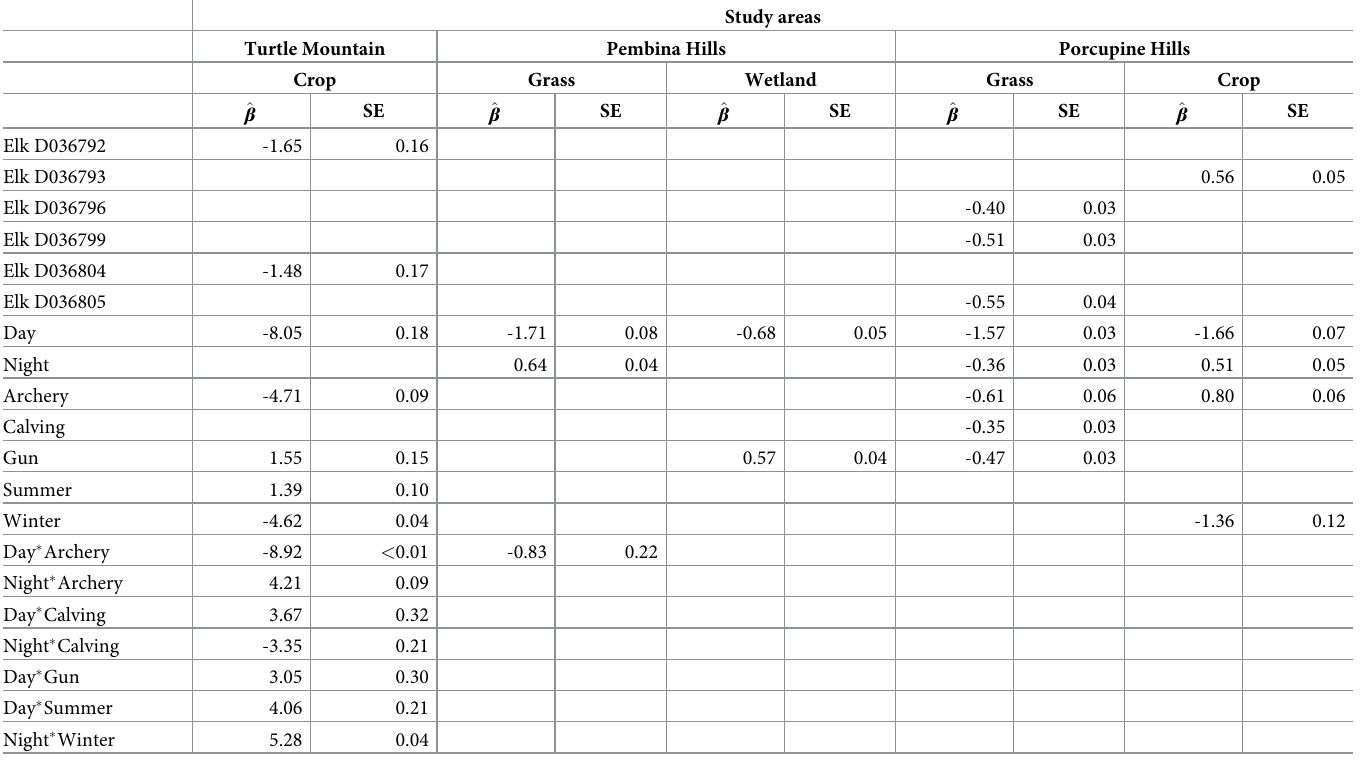
Table 4. Coefficient estimates ( ^ β ) and standard errors (SE) for contributions to log-odds of significant explanatory variables ( α = 0.05; based on Wald-statistics) of the multinomial logit regression models of habitat use in Turtle Mountain, Pembina Hills, and Porcupine Hills study areas, North Dakota, USA (data collected from 2016–17). The 3 study areas were analyzed separately; land covers are the response categories that exhibited significantly different odds of use for the listed predictor level, relative to availability. Individual elk differed from other predictor variables in that only a subset was present in each herd; other predictors were tested in all study